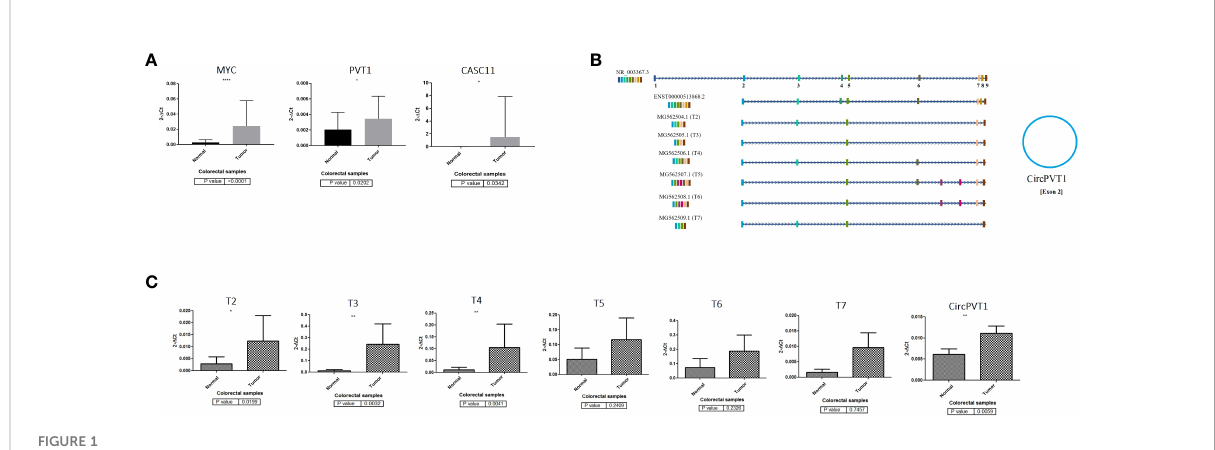
FIGURE 1 PVT1 , CASC11 , and MYC expression analysis in colorectal cancer. (A) PVT1 , CASC11 , and MYC are overexpressed signi fi cantly ( p < 0.05) in CRC tumor samples. (B) PVT1 transcripts and (C) their expression analysis in colorectal tumor samples. Most underrepresented transcripts are overexpressed in colorectal tumors compared to normal margin samples *P<0.05, **P<0.01,